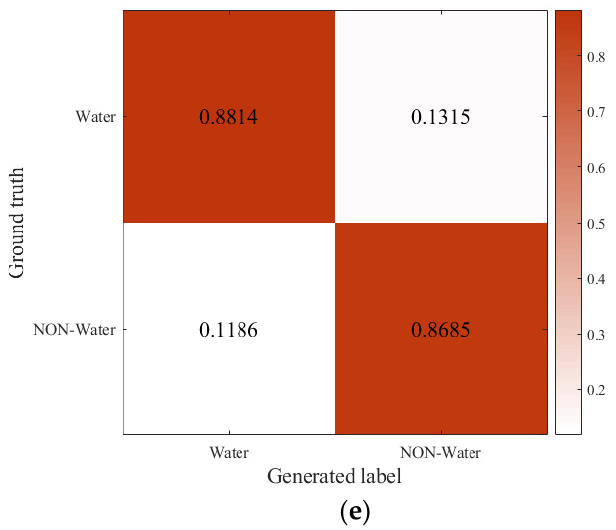
Figure 11. Confusion matrices of different combinations. ( a ) Combination A. ( b ) Combination B. ( c ) Combination C. ( d ) Combination D. ( e ) Combination E.